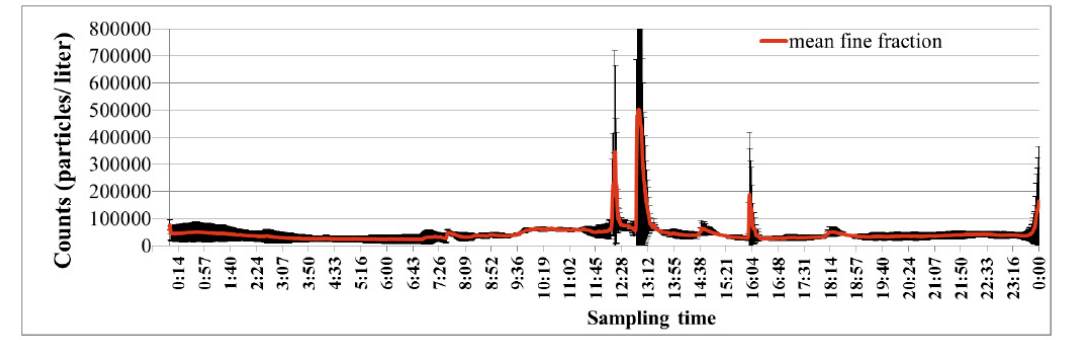
Figure 3. Fine fraction (0.28–1.10 µm) mean obtained for the bakery nonworking days (Sundays) during sampling period.